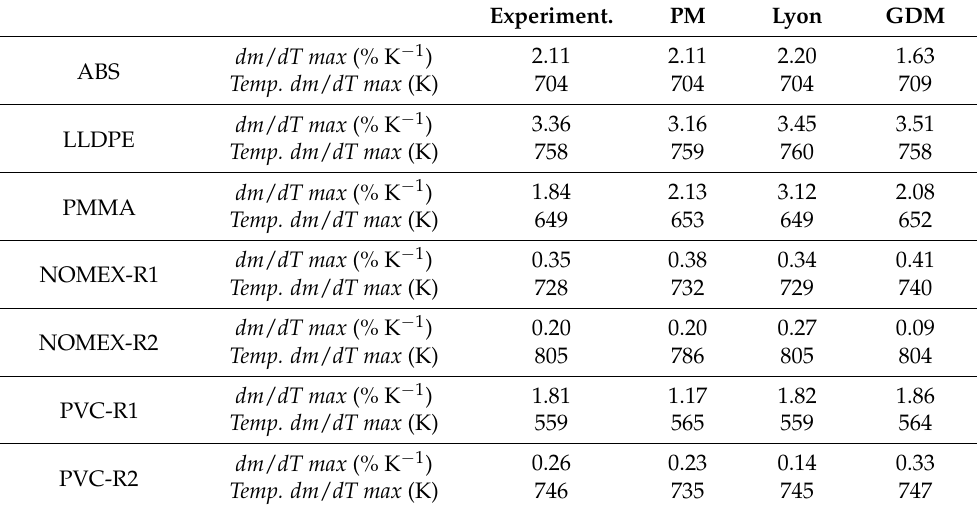
Table 7. Comparison of dm / dT maximum values and temperature with experimental results for five polymer materials.